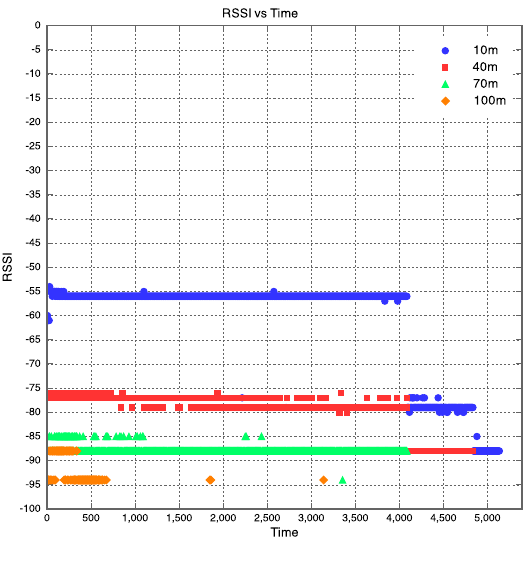
Figure 6. RSSI vs Time for Experiment 1.